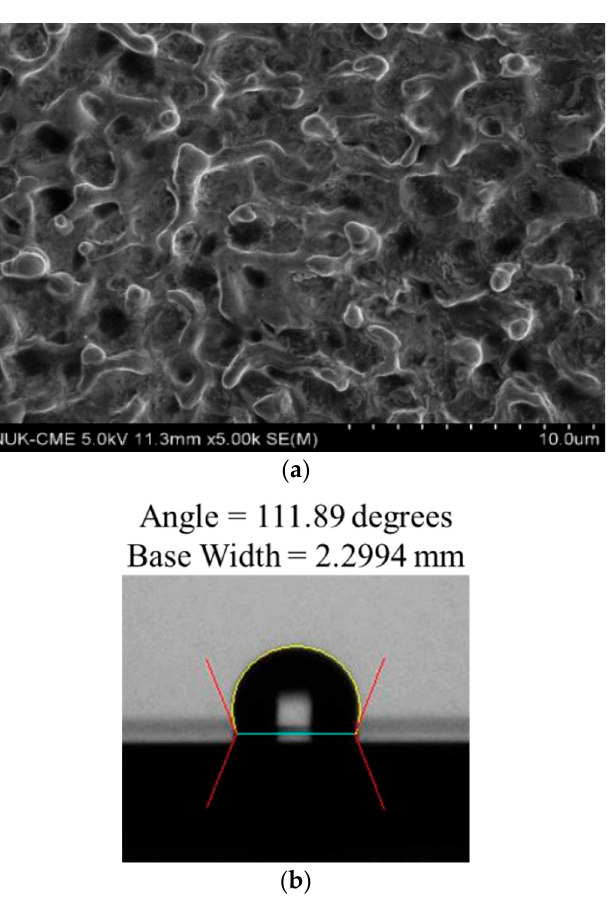
Figure 13. Surface appearance and contact angle for an electrode distance of 20 mm: ( a ) SEM at 5000×; ( b ) contact angle when the cathodic specimen speed of 0.125 mm/s and the applied voltage of 220 V are fixed.